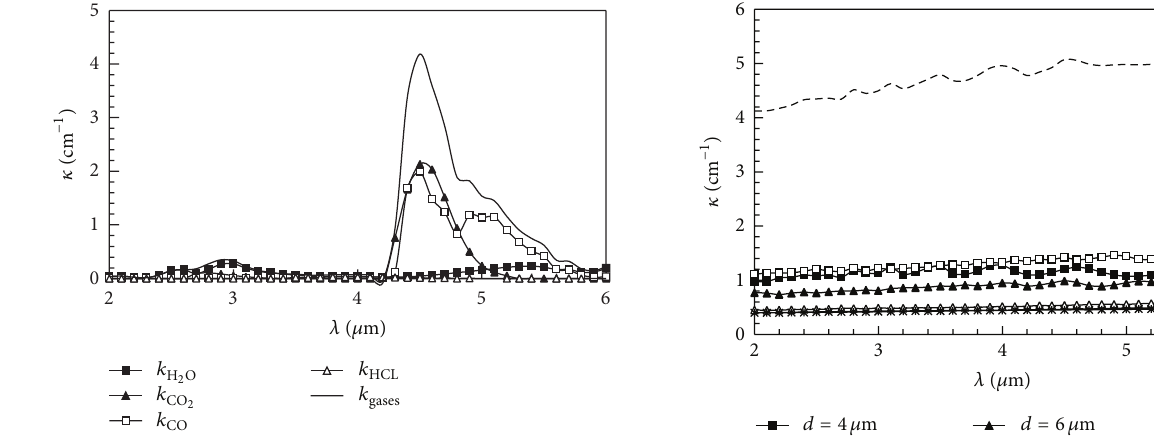
Figure 5: Calculated absorption coefficient of plume gases with WSGG model.